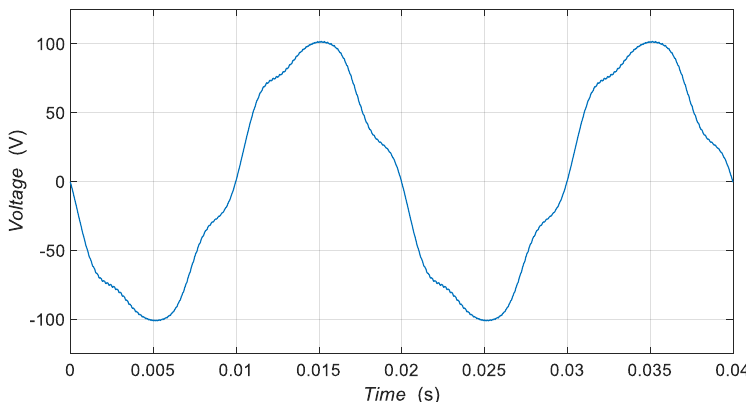
Figure 10. Waveform of generated line-line voltage.